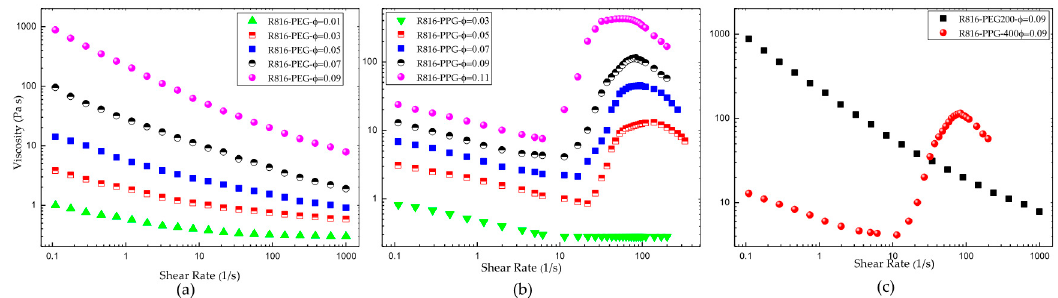
Figure 6. ( a ) Viscosity curves of R816 fumed silica in PEG200 suspensions. ( b ) Viscosity curves of R816 fumed silica in PPG400 suspensions. ( c ) Comparison between the viscosity curves of R816 in PEG200 and in PPG400 suspensions ( φ = 0.09 ) .